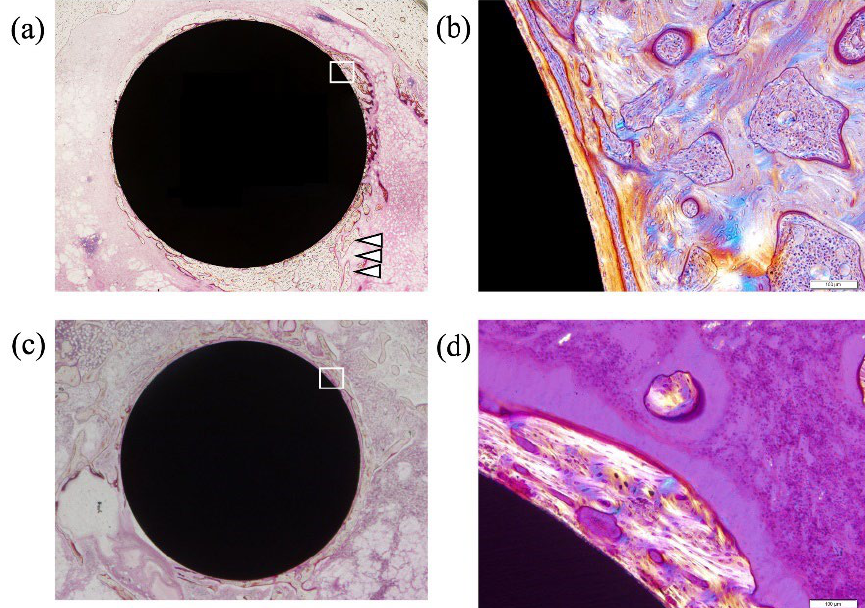
Figure 10. Non-decalcified histological assessment of TiNbSn implanted femurs. TiNbSn rods anodized with sulfuric acid, and untreated TiNbSn rods were implanted in rabbit femurs. Histological assessment was performed six weeks after TiNbSn rod implantation. Arrowheads indicate new bone formation. ( a ) Low-magnification image of anodized TiNbSn rod groups. ( b ) Low-magnification image of untreated TiNbSn rod group. ( c ) High-magnification image of anodized TiNbSn rod group. ( d ) High-magnification image of untreated TiNbSn rod